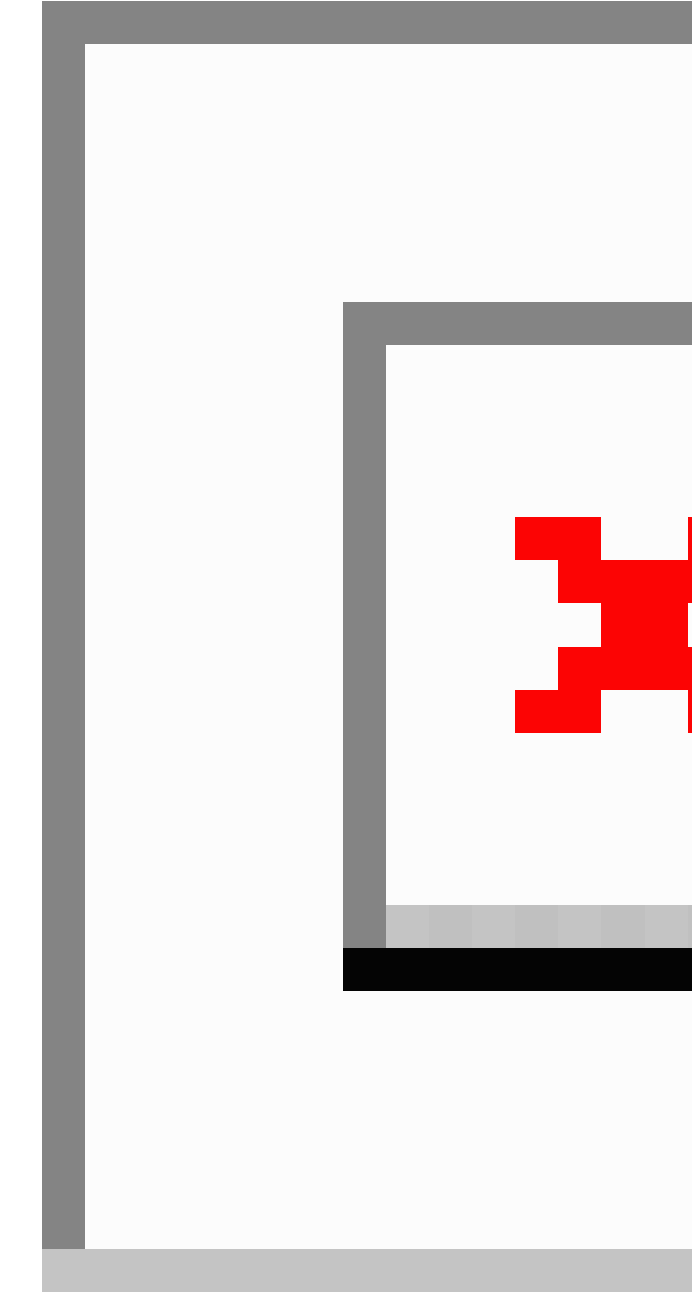
Figure 1. PRISMA flow diagram illustrating the study selection